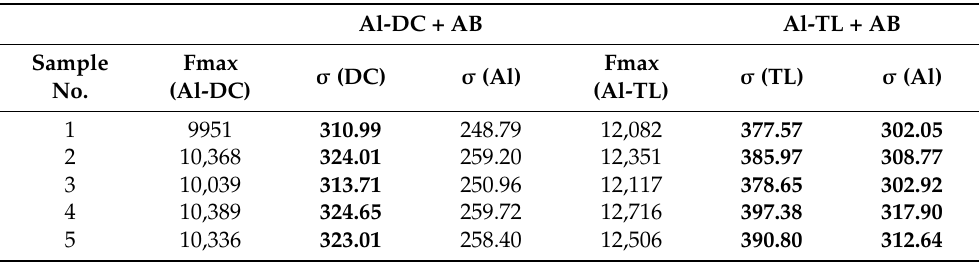
Table 10. Maximum load Fmax [N] and stress σ [MPa] in substrates used in welded-bonded joints (epoxy-based adhesive).